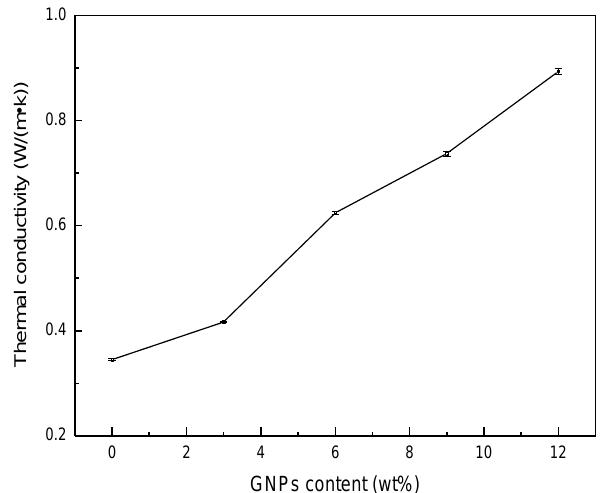
Figure 2. Thermal conductivity of the WPCs as a function of GNPs contents.